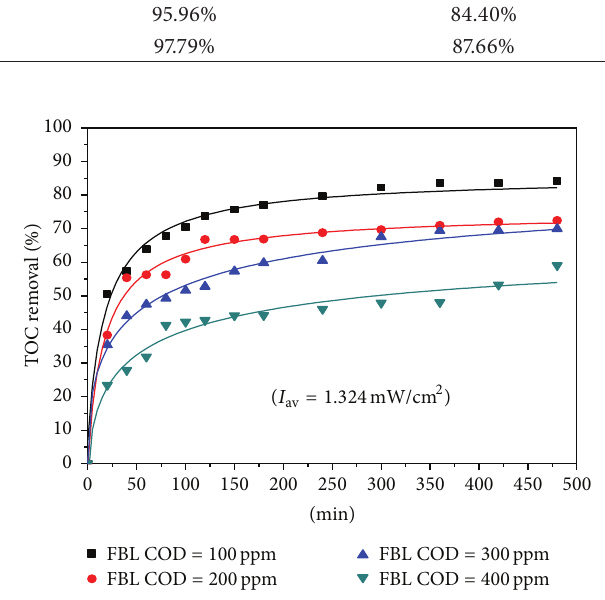
Figure 7: TOC removal % versus time with Ni-Zn ferrite/TiO 2 (COD | 𝑡=0 = 100–400 ppm) to treat FBL dye (dosage = 5 g/L; 𝐼 av = 0.1324 mW/cm 2 ).